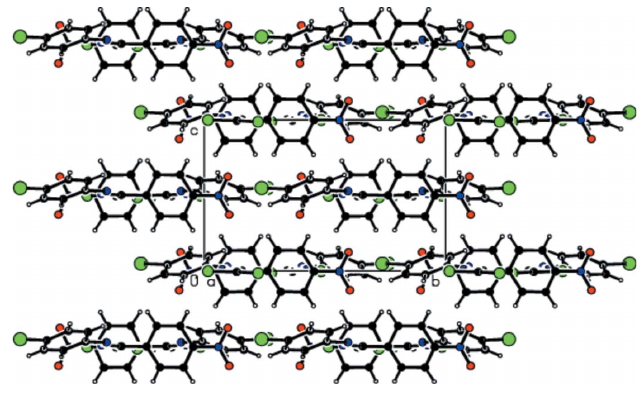
Figure 3 Packing in the crystal structure of (I) showing chains running parallel to the a-